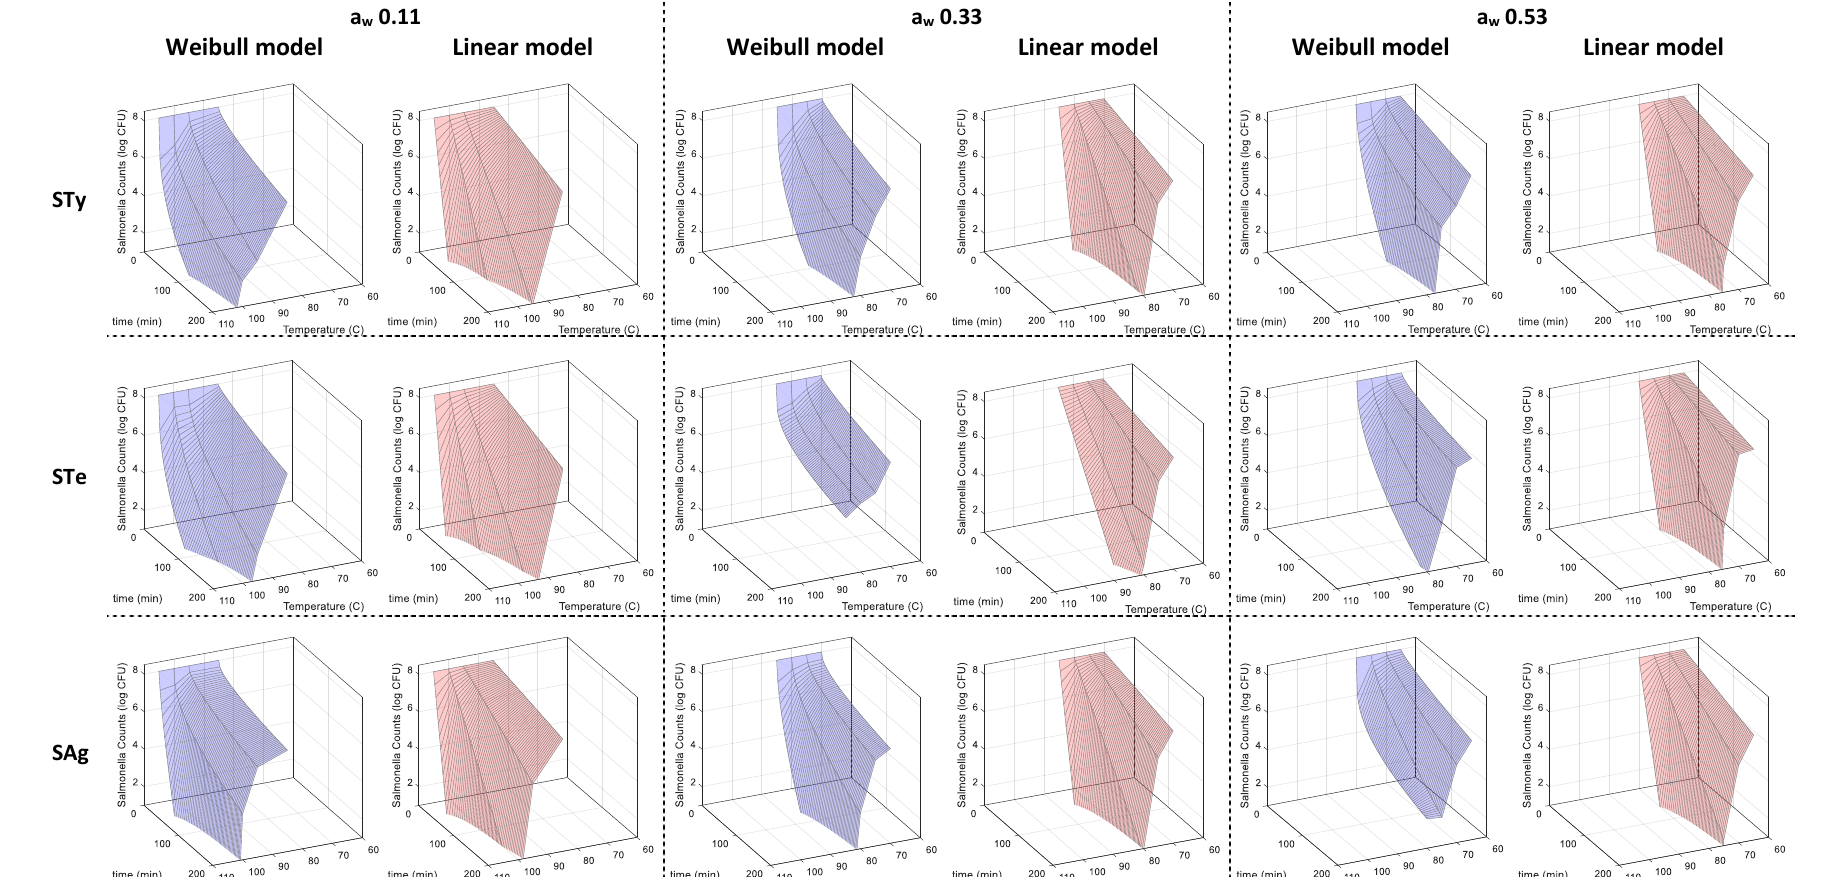
Figure 1. Thermal inactivation rates of Salmonella enterica serovars Typhimurium, Tennessee and Agona in toasted oat cereal (TOC affected by water activity (a w ) and temperature). The Weibull model fitting is represented in blue and the linear model fitting is represented in red. STy, STe and SAg are abbreviations for serovars Typhimurium, Tennessee and Agona, respectively.